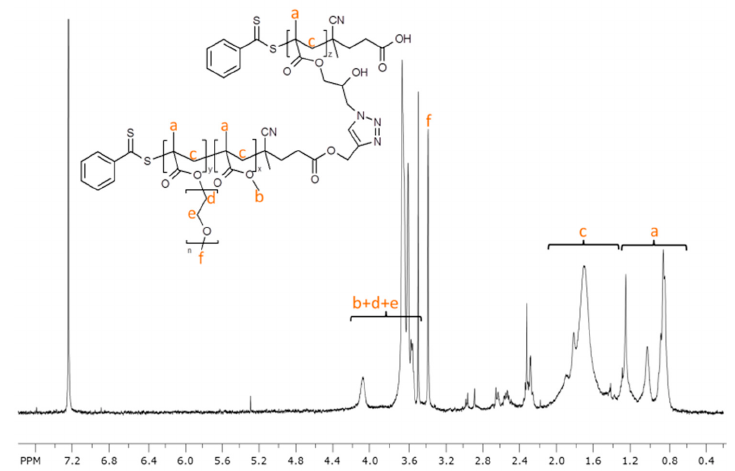
Figure 5. 1 H-NMR spectrum in CDCl 3 of PGMA- g -(PMMA- b -POEGMA) block copolymer brush.